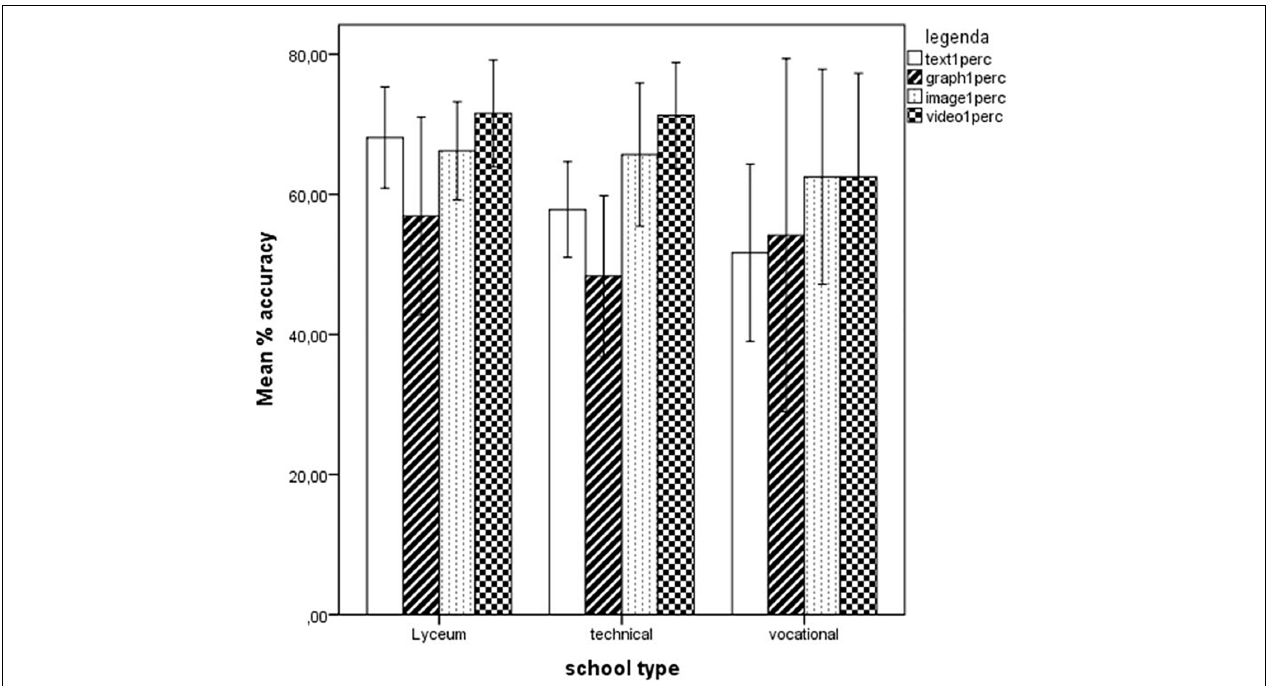
FIGURE 4 | Performance of students from the three different school types on the four subscales Text, Graph, Image, and Video, expressed as percent scores. Error bars illustrate 95% Confidence Intervals for the Mean.